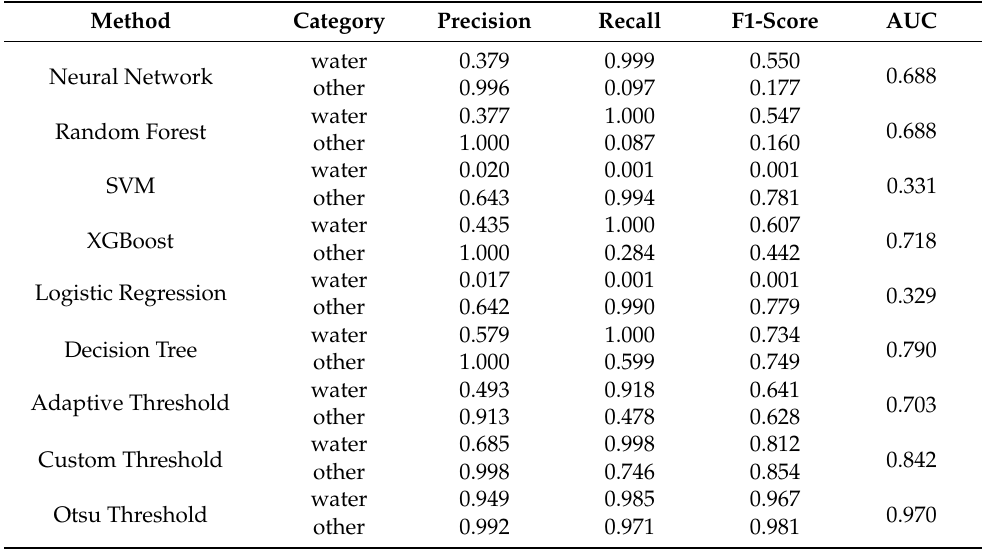
Table A6. Statistics of various indexes of each algorithm in Area1 on October 4.